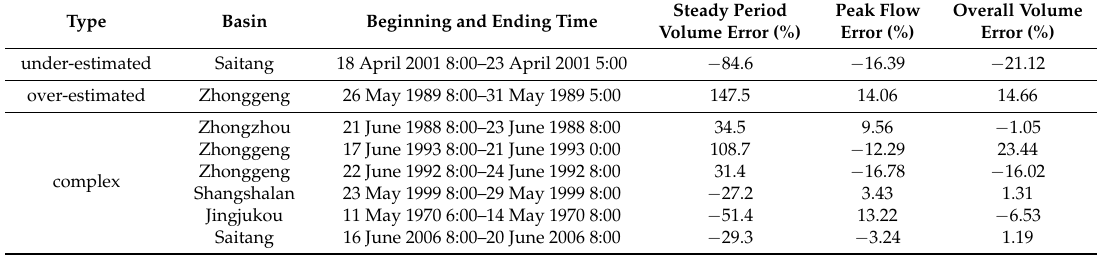
Table 12. Error statistics of typical floods.